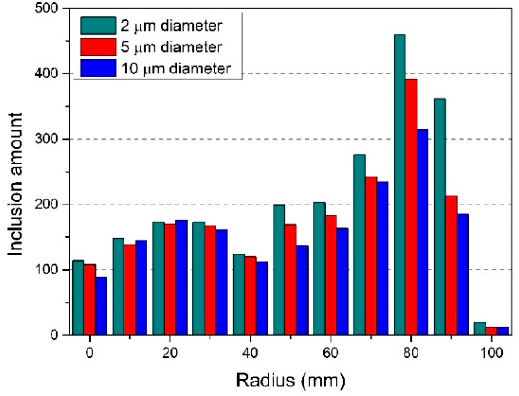
Figure 16. Effect of particle diameter on the inclusion distribution along radius in ingot.